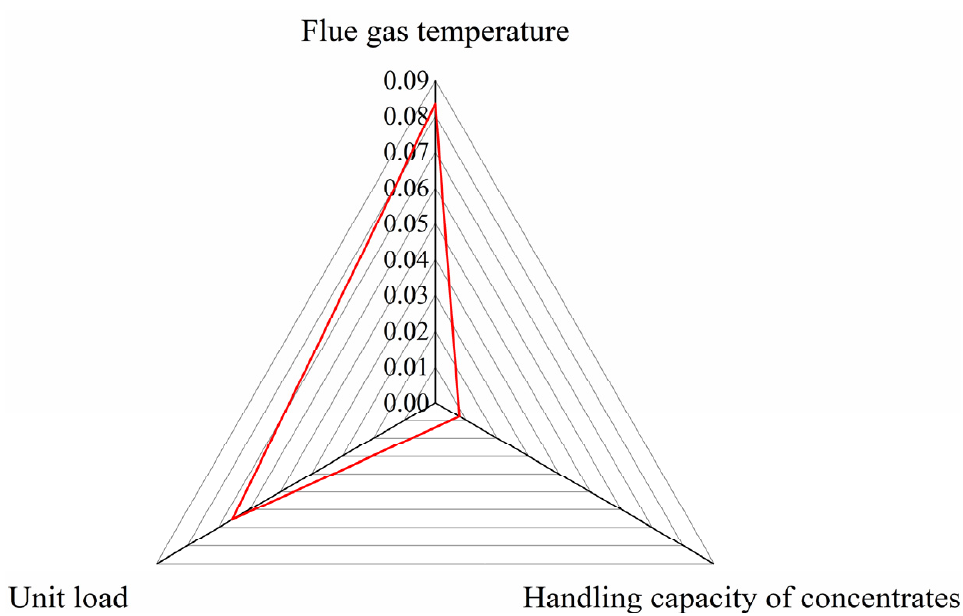
Figure 6. The absolute value of the sensitivity coefficient of factor A to C per .